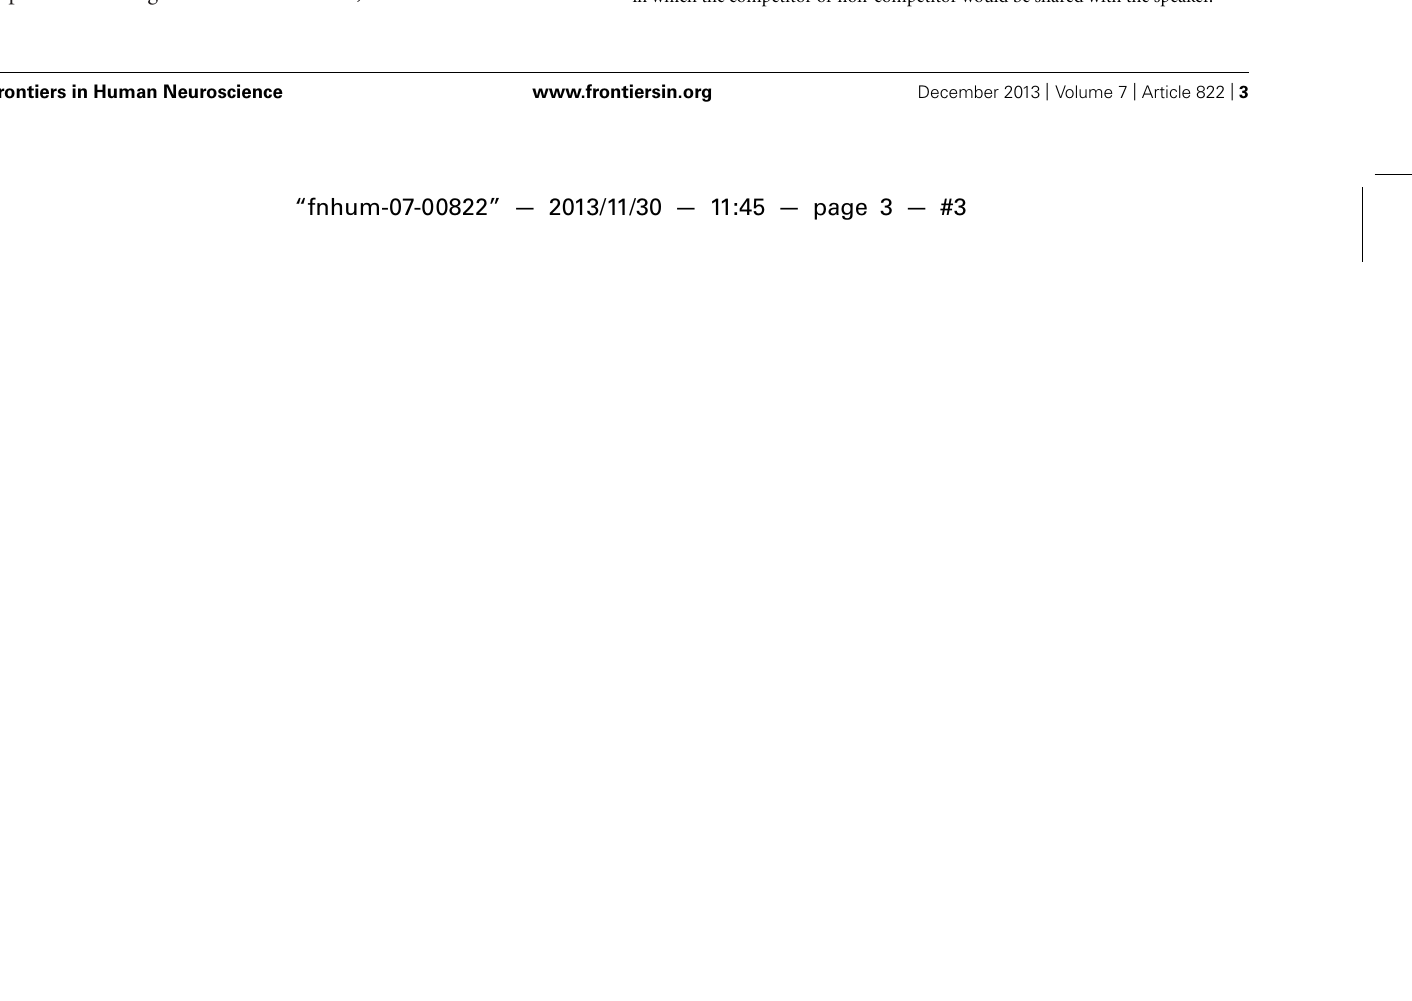
Chinese should show less egocentric interference than Western- ers from the earliest moments of referential processing – in other words, the onset of the cultural difference should be simultane- ous with the onset of the overall effect of egocentric interference ( Figure 1A